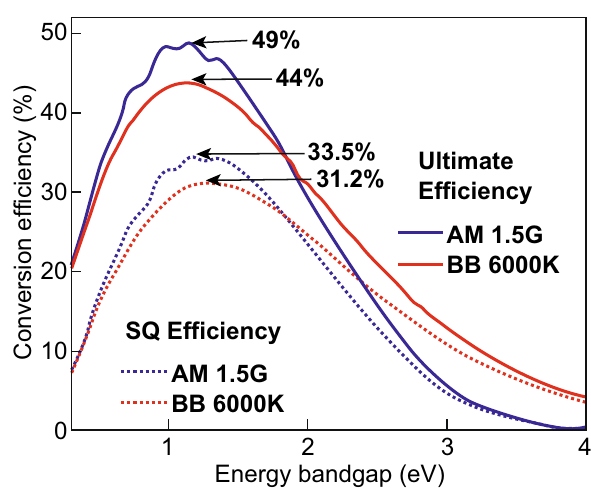
Fig. 5 Ultimate conversion efficiency and Shockley–Queisser limit of single-junction solar cells as a function of the bandgap. A black- body spectrum at 6000 K and an AM 1.5G spectrum were used for the